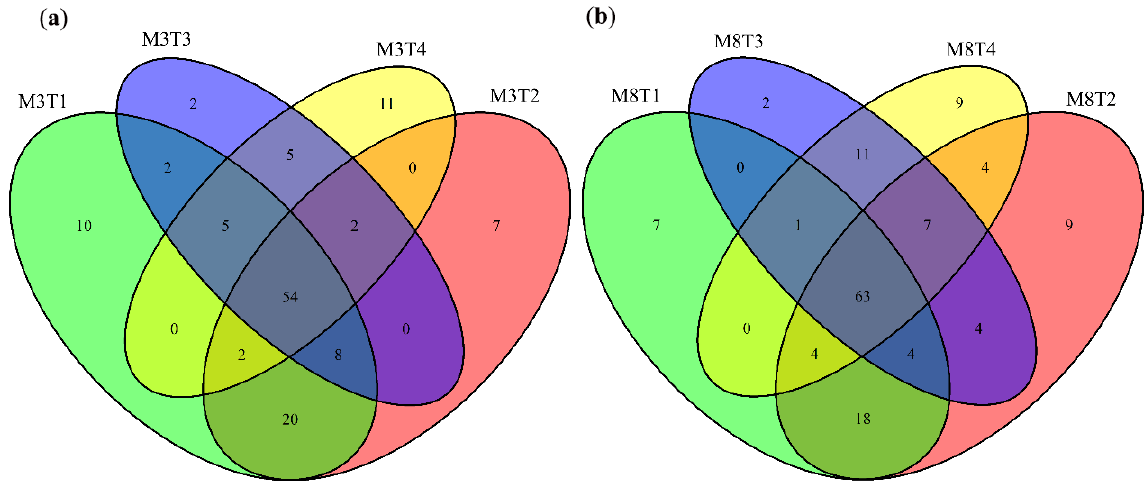
Figure 3. Venn diagrams of the detected miRNAs among ( a ) the seeds of ‘M3’, and ( b ) the seeds of ‘M8’, at four different developmental stages.